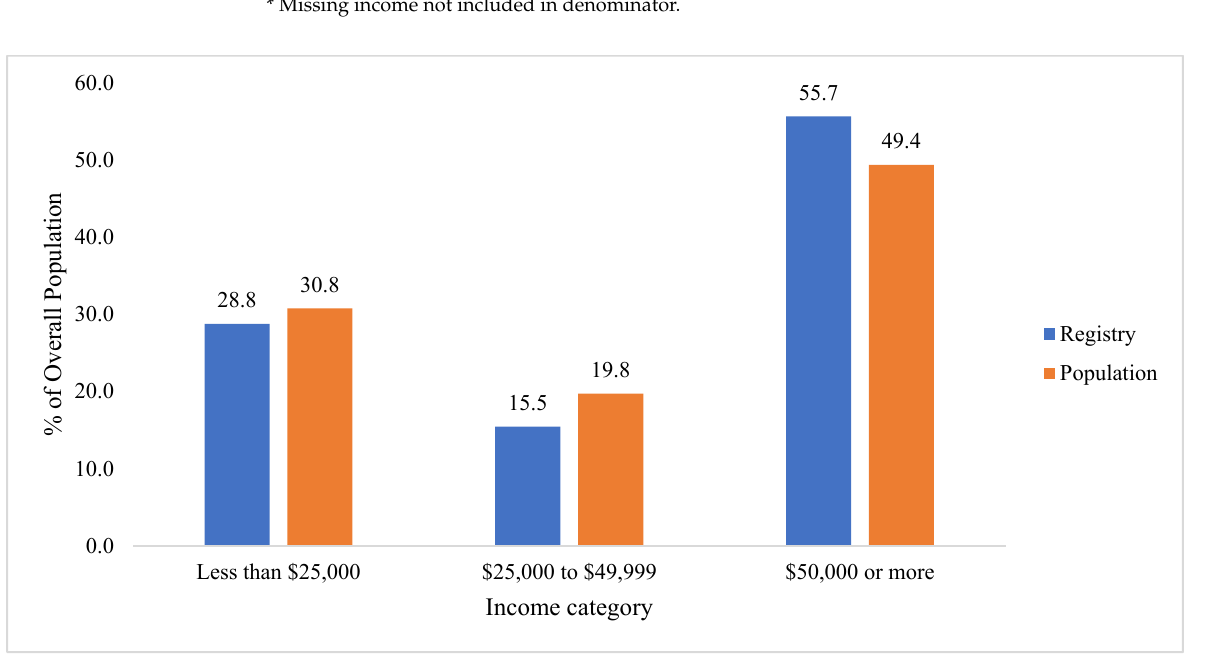
Figure 5. Comparison of proportions by household income of WTCHR (Registry) residents to population south of Canal Street in Lower Manhattan in 2000.